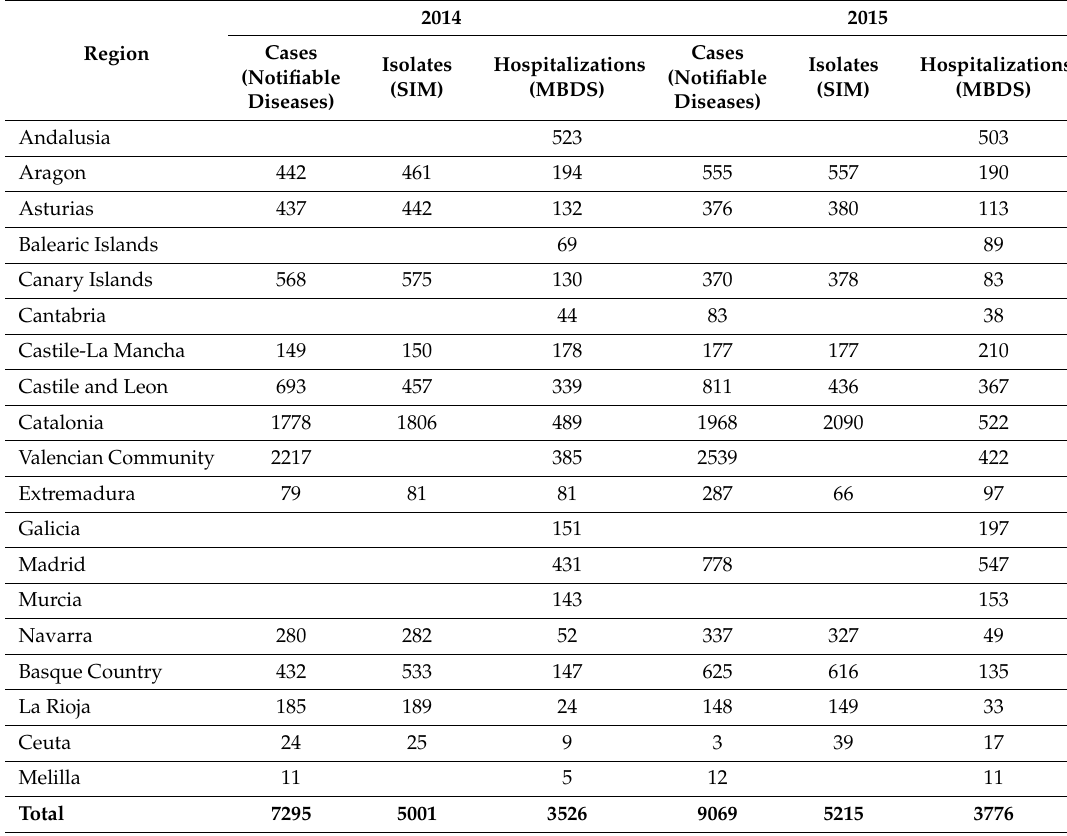
Table 7. Summary of results from the different sources by region. SIM = Microbiology Information System; MBDS = Minimum Basic Data